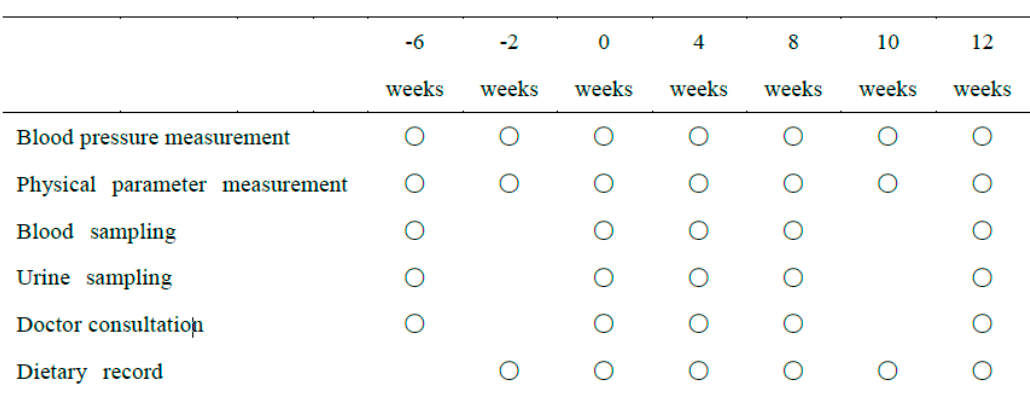
Figure 1. Flow chart of participant recruitment.